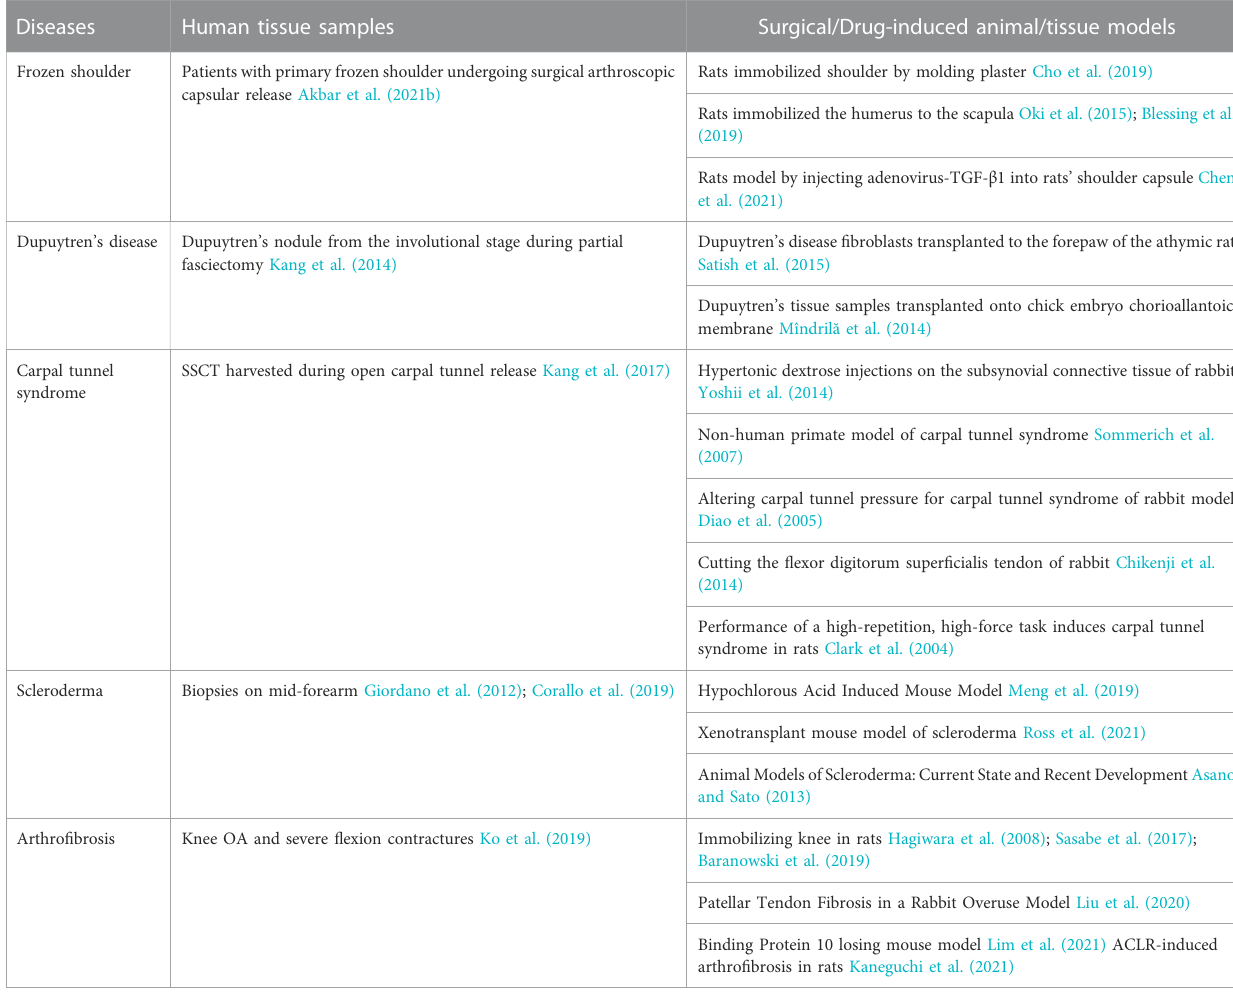
TABLE 3 Obtaining human Tissue samples and animal models utilized in the study of FLDs. Diseases Human tissue